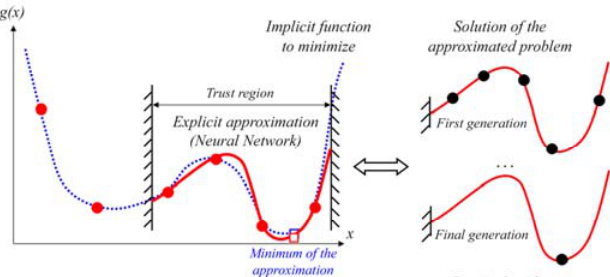
Fig. 5. Illustration of the Surrogate Based Optimization approach